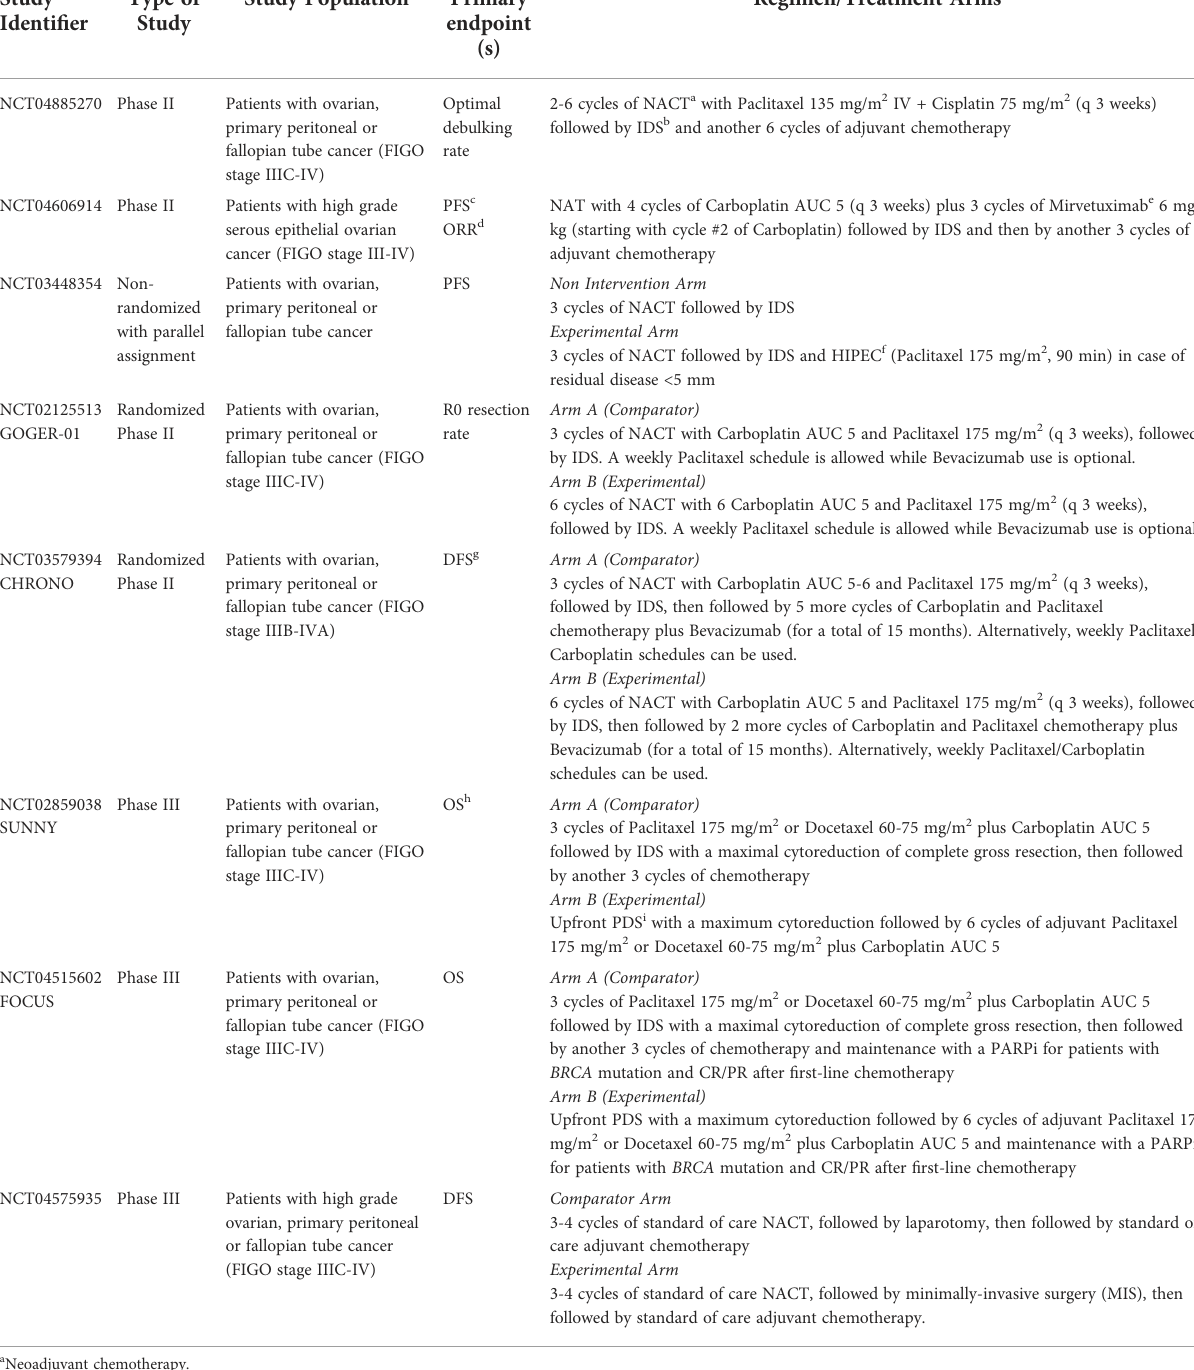
TABLE 2 Selected current phase II and III clinical trials investigating neoadjuvant chemotherapy in epithelial ovarian